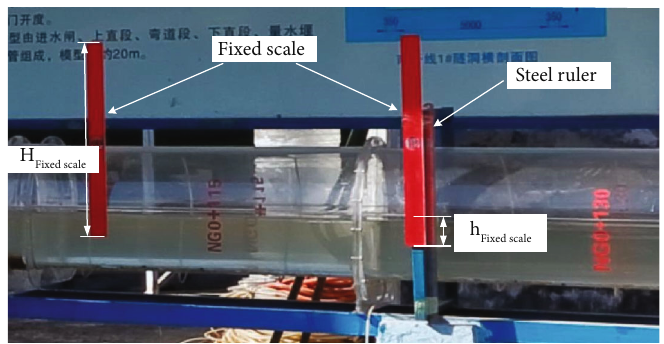
Figure 3: Schematic diagram of water level